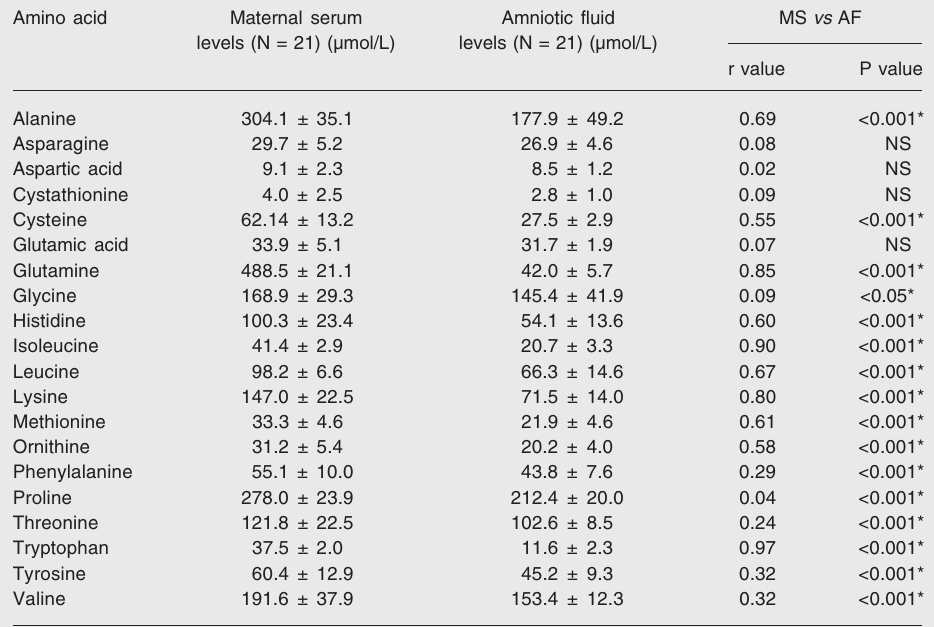
Table 3. Correlations between maternal serum (MS) and amniotic fluid (AF) amino acid levels in the gastroschisis group. Amino